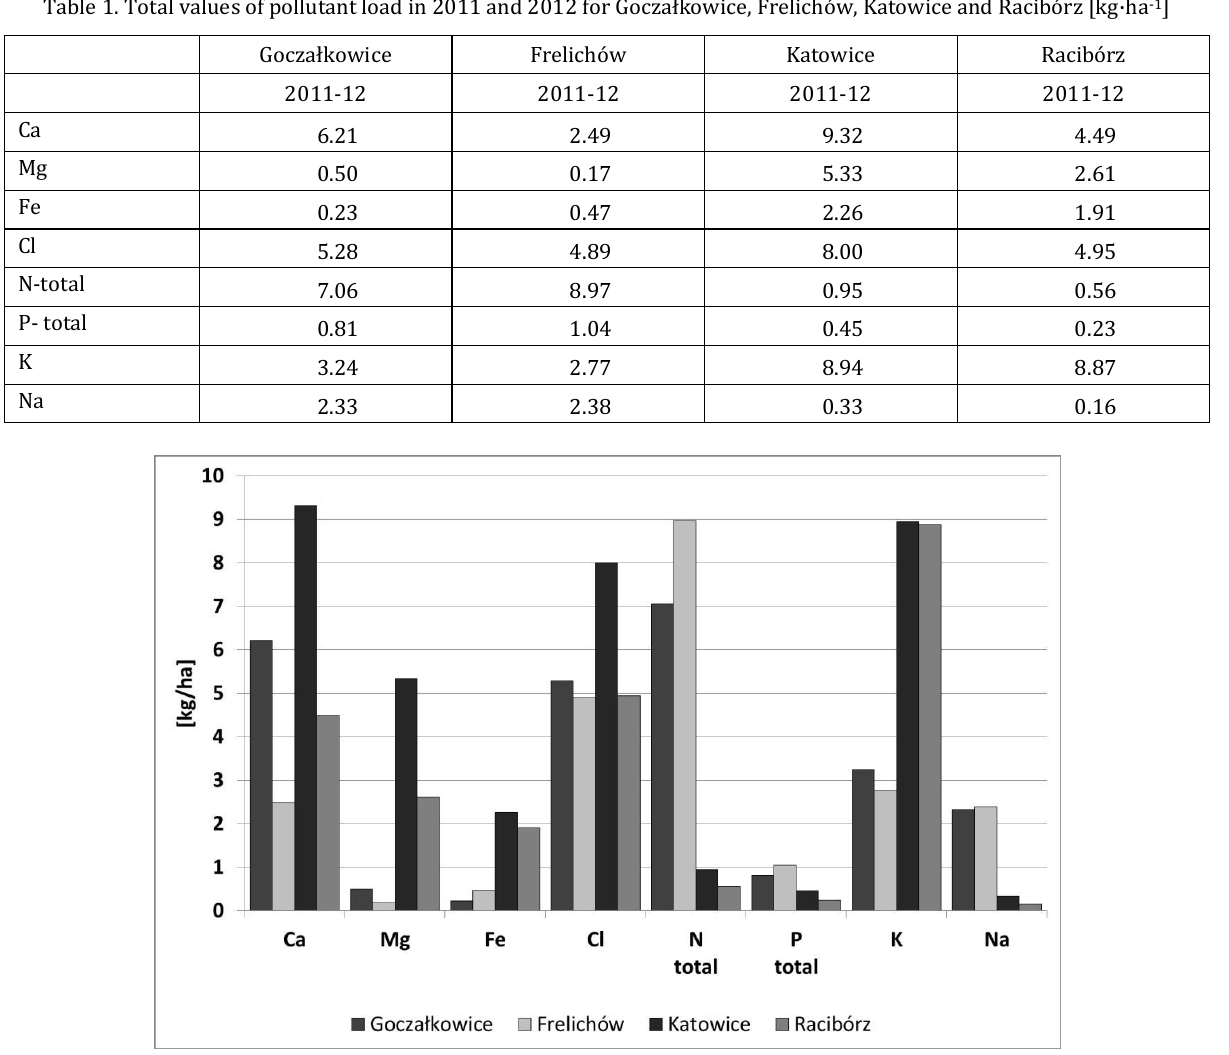
Fig. 6. Total values of wet deposition for Goczałkowice, Frelichów, Katowice and Racibórz between 2011-2012 [kg·ha -1 ] Table 2. Mean pollutant load values for seasons in 2011 and 2012 for Goczałkowice, Frelichów, Katowice and Racibórz [kg·ha -1